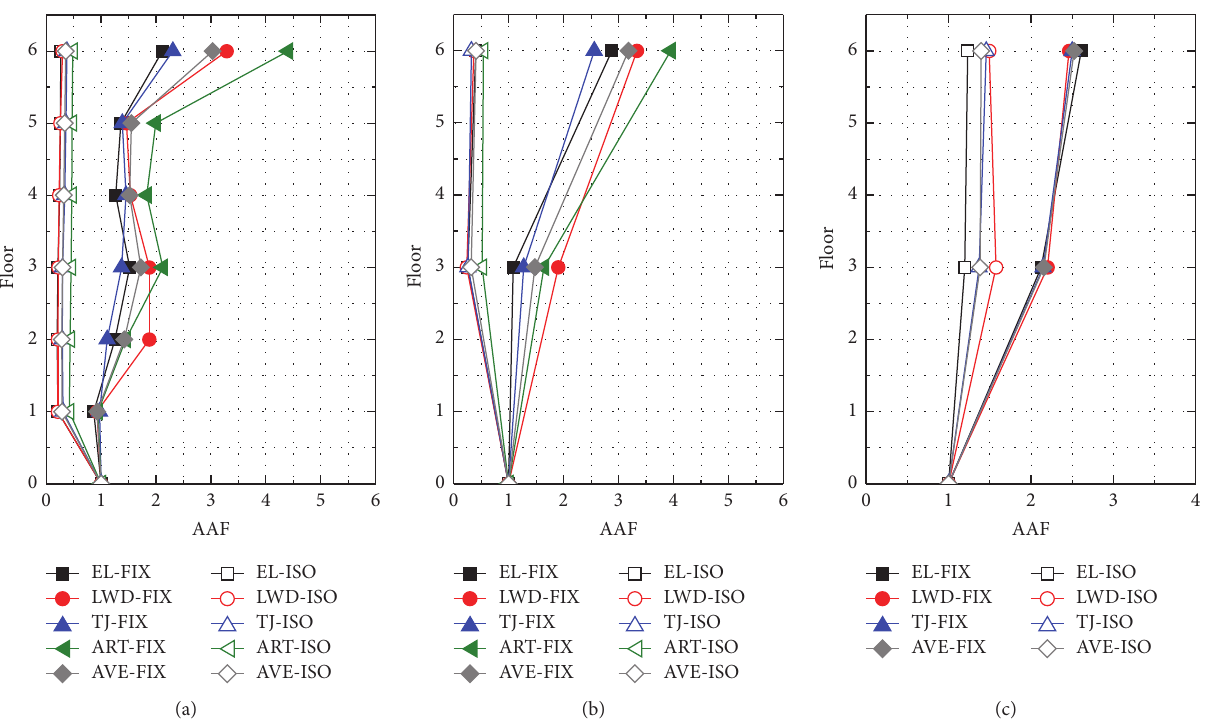
Figure15:ComparisonsofAAFfortheisolatedandfixedstructuresundermajorearthquakes:(a)direction x; (b)direction y; and(c)direction z .